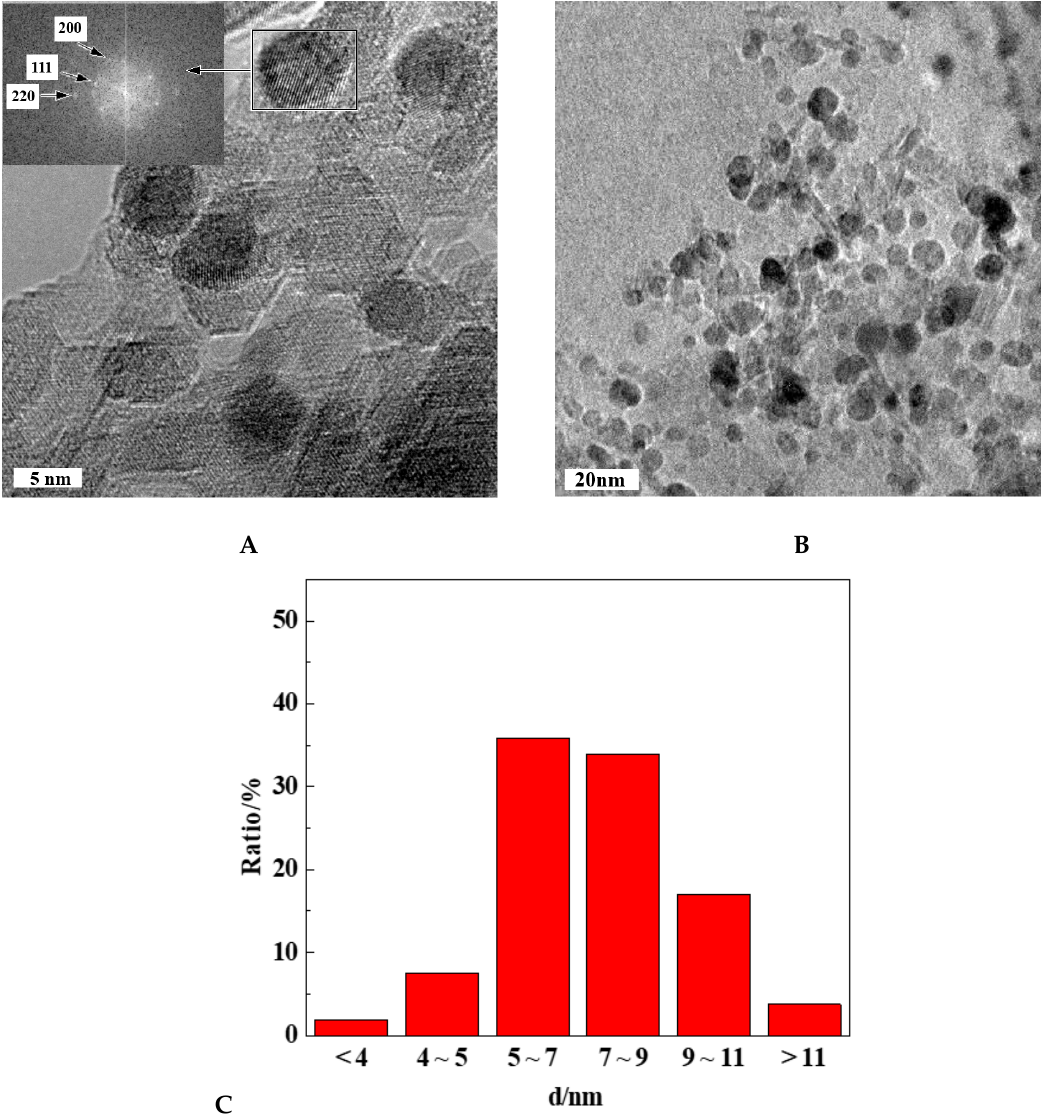
Figure 1. ( A, B ) TEM images and ( C ) particle size distribution profiles of Cu-Pd/(Mg) γ -Al 2 O 3 catalysts.